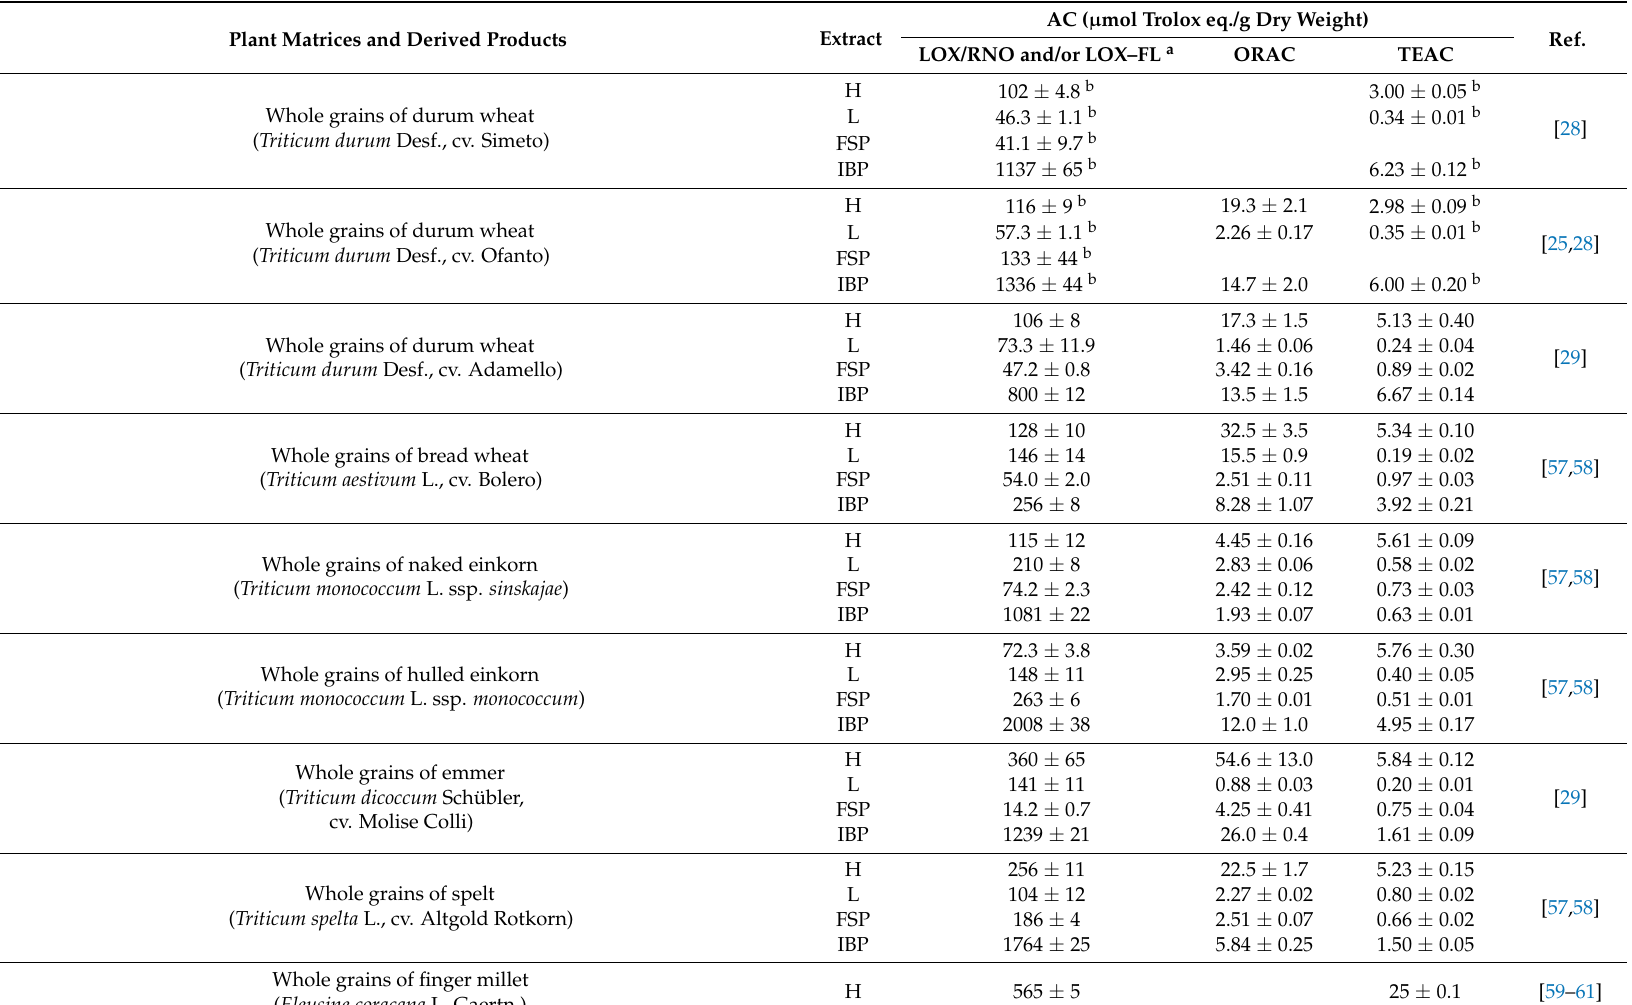
Table 3. Antioxidant Capacities of different plant samples as evaluated by LOX/RNO and/or LOX–FL methods in comparison with TEAC and ORAC assays. Plant Matrices and Derived